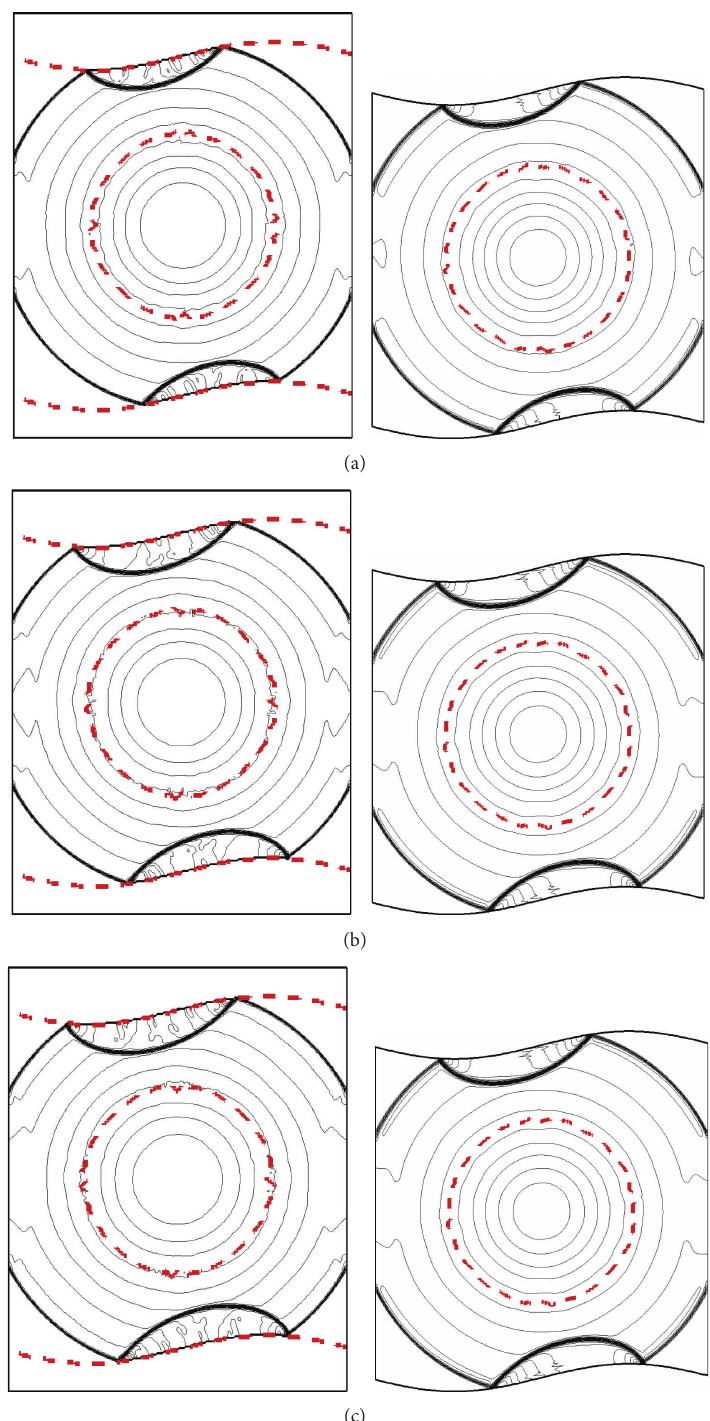
Figure 10: Comparisons between numerical results by GFM-based algorithm (left) and body-fitted-grid method (right). Red dashed line indicates material interface, (a) 𝑡 = 78.86 ms, (b) 𝑡 = 83.07 ms, and (c) 𝑡 = 84.73 ms (Case